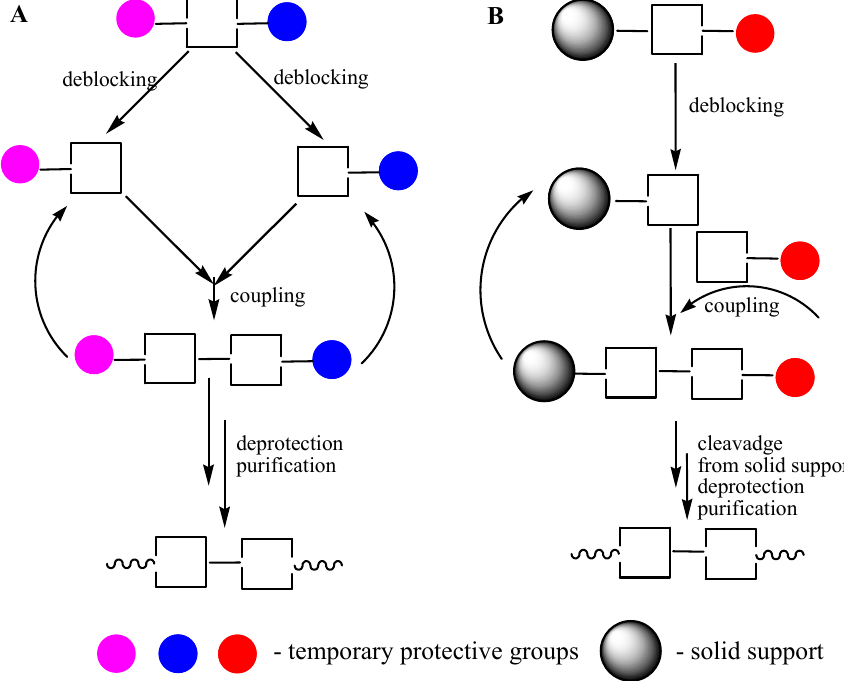
Figure 2. Oligomer assembling. ( A ) Block method, liquid phase synthesis (LPS). ( B ) Sequential addition of synthons, solid phase supported synthesis